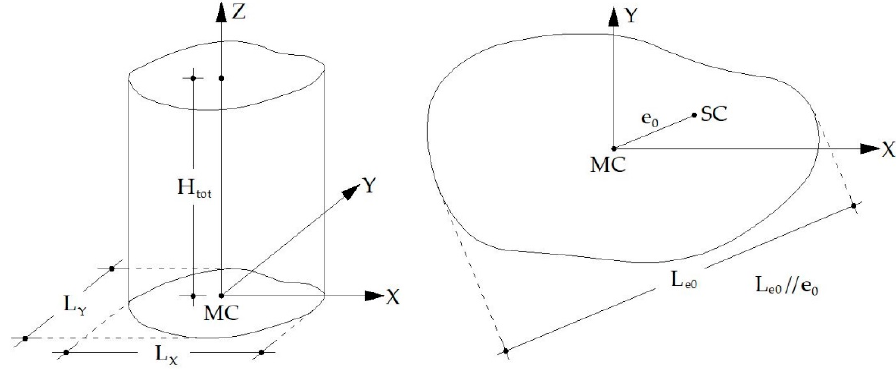
Figure 5. Definition of the selected structural parameters for the input vectors of MLP networks. 3 structural parameters) were used as elements of the input vectors of MLP networks. The general form of these input vectors (dimensions 15 × 1) is given by Equation (6).